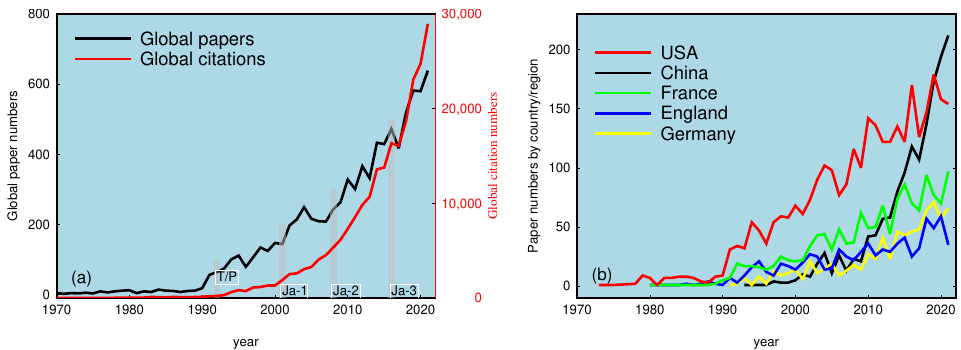
Figure 2. The number of publications based on WoS data from 1970 to 2021: ( a ) the global annual published paper, citations, and launch year of the T/P series satellite altimeter, and ( b ) the annual published paper counts for the top five